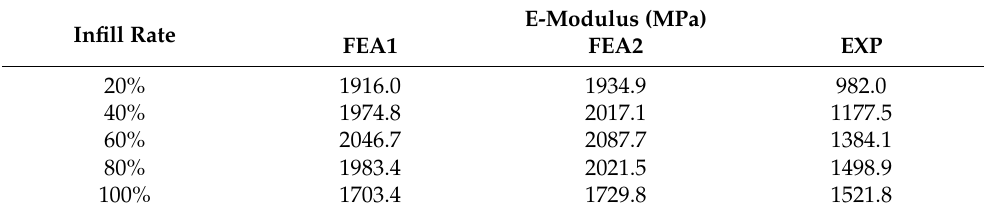
Table 4. Tensile modulus of the printed specimens with geometrically determined cross-section.